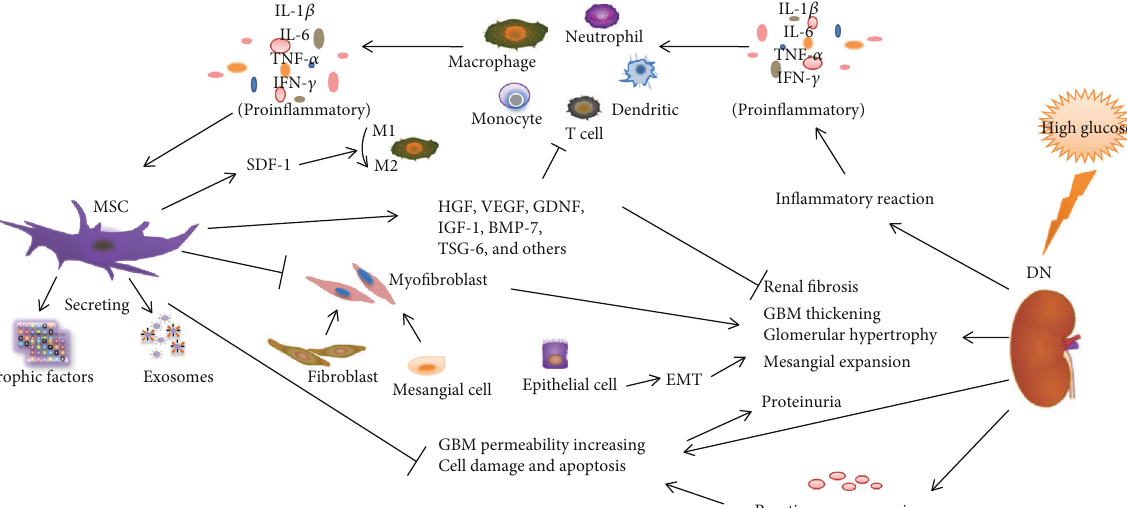
Figure 1: MSCs attenuate the pathological changes and clinical manifestations of DN by regulating in fl ammatory reaction, fi brotic response, and immune